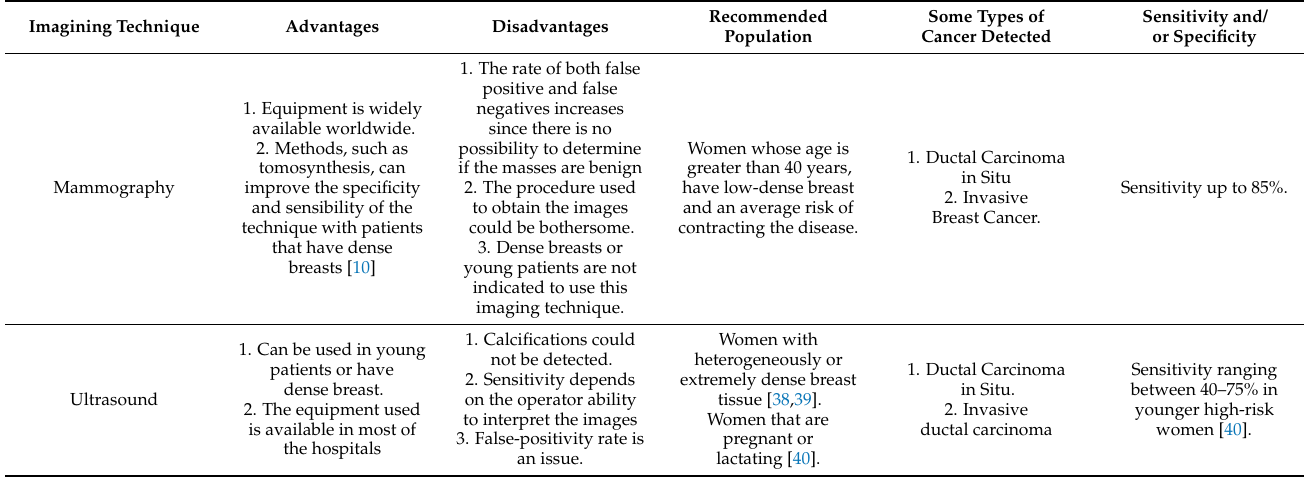
Table 1. Summary of the used breast image generation